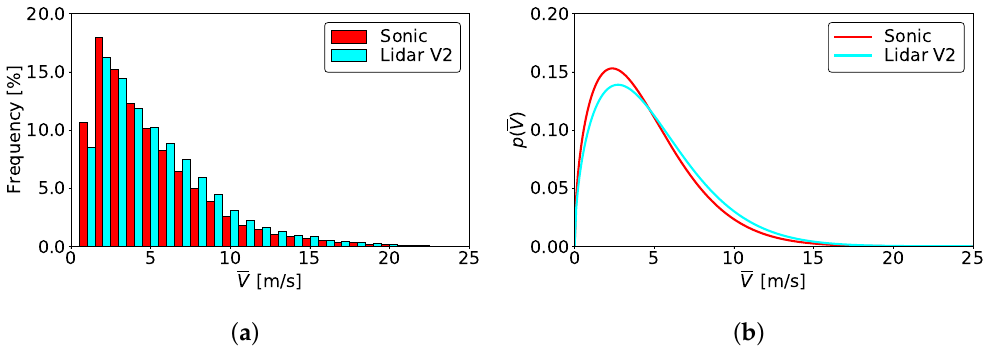
Figure 16. Velocity distribution at 57 m height. ( a ) Histogram of frequency of occurrence of 10-min average wind speed; ( b ) Weibull distribution of the PDF obtained from the measured